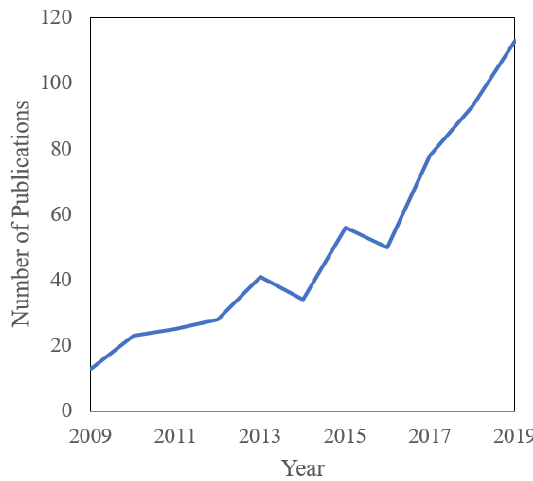
Figure 1. Annual number of publications returned from a scopus search using “renewable ammonia production” as